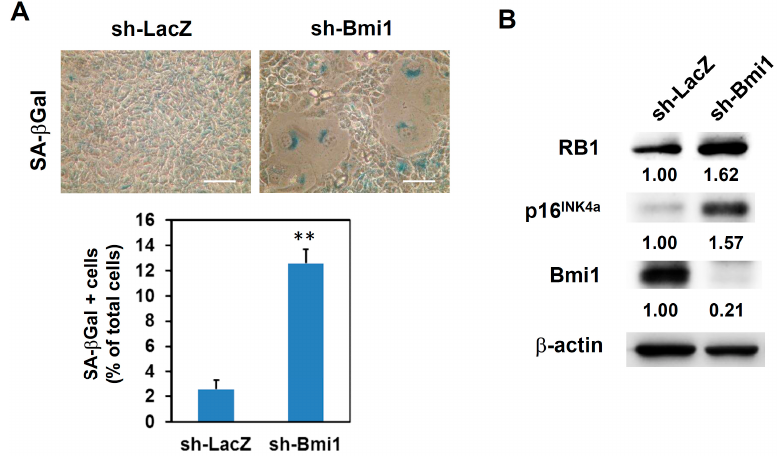
Figure 5. Knockdown of Bmi1 activates senescence pathway in SAS cells. SAS cells were transduced with sh-Bmi1 or sh-LacZ carrying lentivirus and selected with 2 μ g/mL puromycin for 3 days. ( A ) sh-LacZ or sh-Bmi1 transduced SAS cells were harvested by trypsin/EDTA and seeded into 12-well-plate at a density of 2 × 10 4 cells/well. The senescent cells were determined by SA- β -Gal staining at 72 h post seeding. Scale bar: 50 μ m. **, p < 0.01; ( B ) The expression of p16 INK4a , RB1, or Bmi1 was determined by Western blot. β -actin was used as an internal control. The inserted numbers indicate relative expression levels as compared with sh-LacZ group.